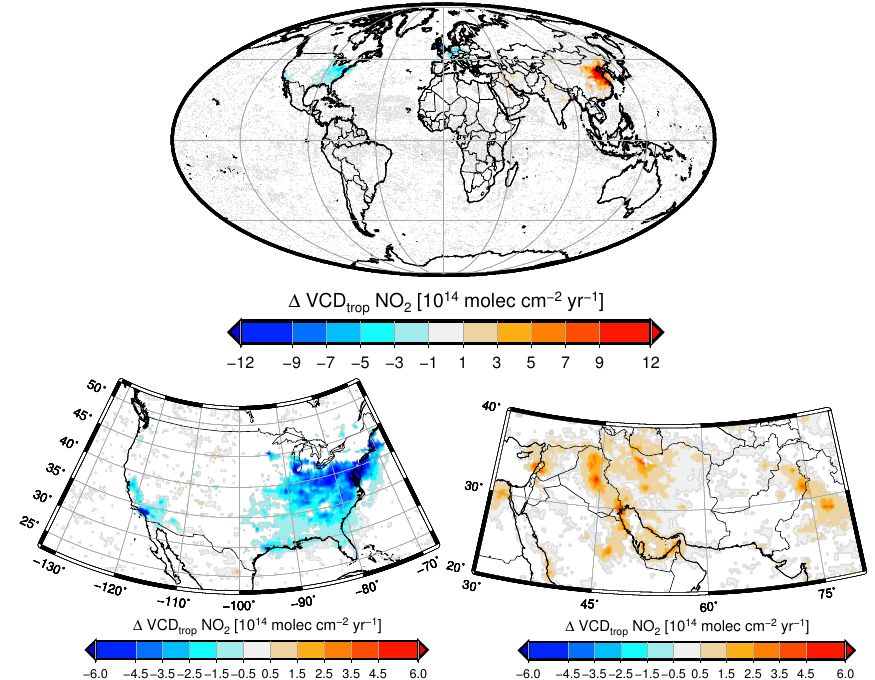
Fig. 14 : Slope ω of the linear trend component of the levelshift trend model (Eq. 3), applied Fig. 15. Slope ω of the linear trend component of the level shift trend model (Eq. 3) applied to monthly averages of GOME and SCIAMACHY to monthly averages of GOME and SCIAMACHY measurements from 1996-2011, gridded to measurements from 1996–2011, gridded to 0.25 ◦ . Those grid cells where the two-sided p value for a hypothesis test whose null hypothesis 0.25°. Those grid cells where the two-sided p-value for a hypothesis test whose null hypothesis is that the slope is zero is larger than 0.05 are excluded from the plot. is that the slope is zero is larger than 0.05 are excluded from the plot. Table 3. Annual growth rate 1 VCD trop NO 2 from the level shift model (Eq. 3) and the multi-instrument fit (Eq. 9) for the regions shown in 50 Fig. 2. The relative trends have been computed relative to the 1996 annual mean. Region Level shift model (orig. GOME data) Multi-instrument